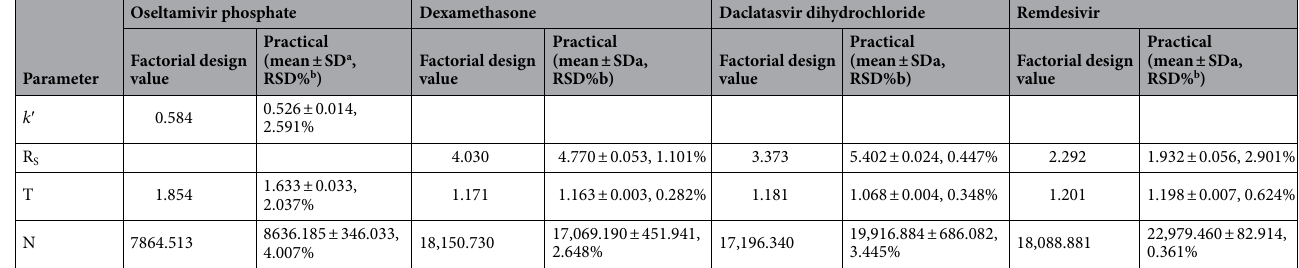
Table 4. System suitability parameters for RP-UPLC-UV determination of oseltamivir phosphate/ dexamethasone/daclatasvir dihydrochloride/remdesivir mixture. a Standard deviation (4–8 replicates at three different days). b Percentage relative standard deviation (4–8